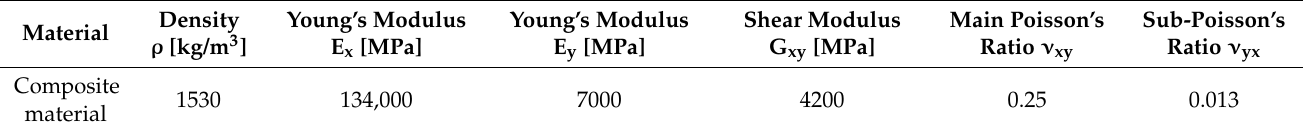
Table 6. Mechanical properties according to fiber orientation.